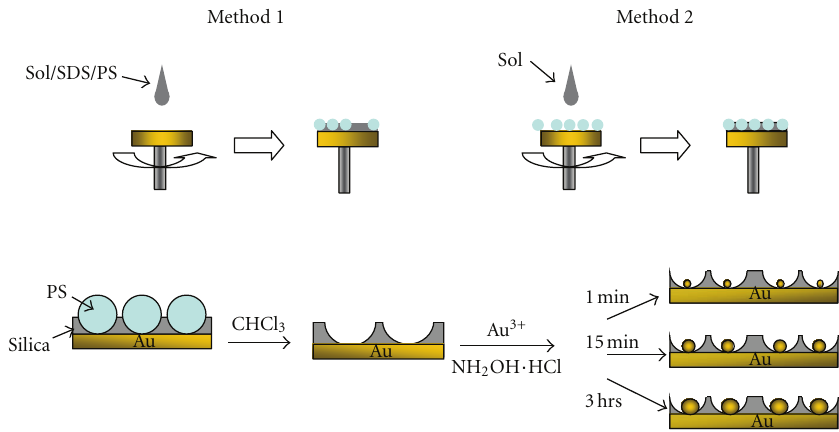
Figure 1: Simplified cartoon that shows the fabrication of silica nanowells on the gold electrode and the subsequent enlargement of the conductive domains exposed after template